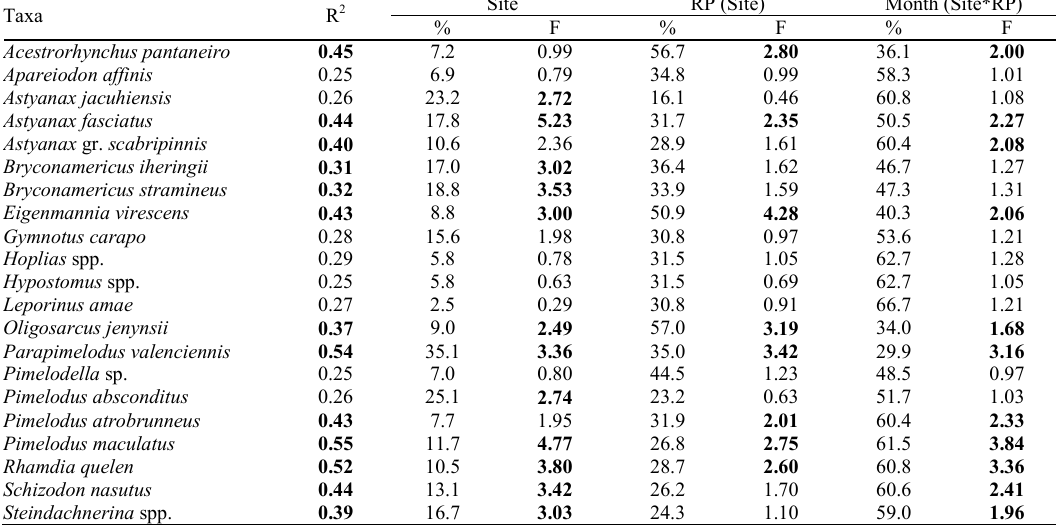
Table 2. ANOVA nested results in the most abundant taxa density variation in studied environments in the three reproductive periods, between October 2001 and March 2004. Numbers in bold represent